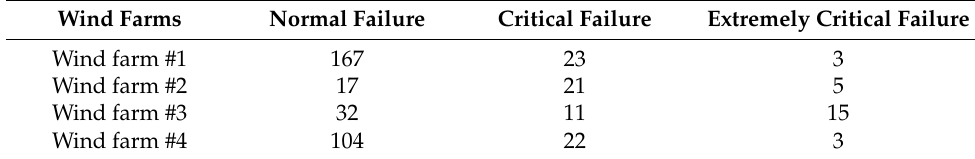
Table 4. Failure criticalities by wind